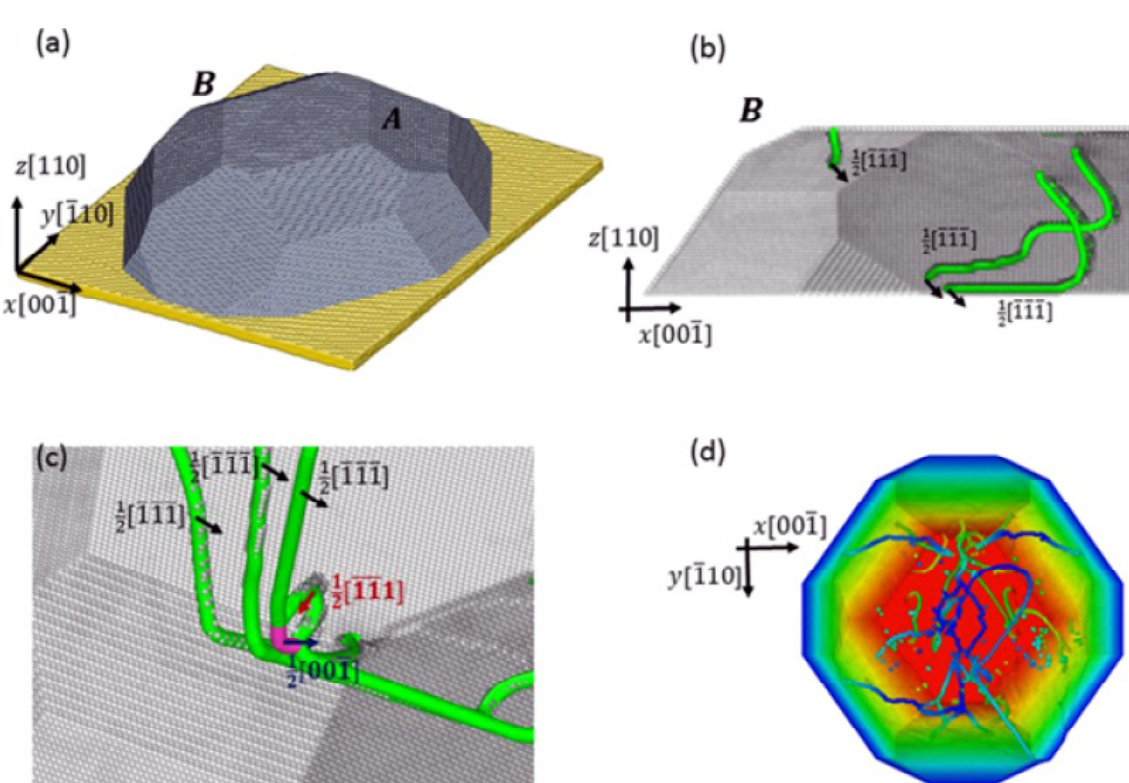
Fig. 31. MD simulation of a 20.8nm high Fe nanoparticle under compression. (a) The two top vertices marked with “A” and “B” are the points where dislocations nucleate. (b) A three-dislocation pile-up formed at B is shown (all the atoms were removed except those in the dislocation cores) (c) A view from the bottom on the dislocation pile-up shown in (b) slightly after the front 1/2[ 1 1 1 ] dislocation in the pile-up splits into [00 1 ] and 1/2[ 1 1 1] dislocations. (d) A bottom view into the particle after cross-split. The color represent height with red being the height of the top facet and blue the bottom. Reprinted with permission